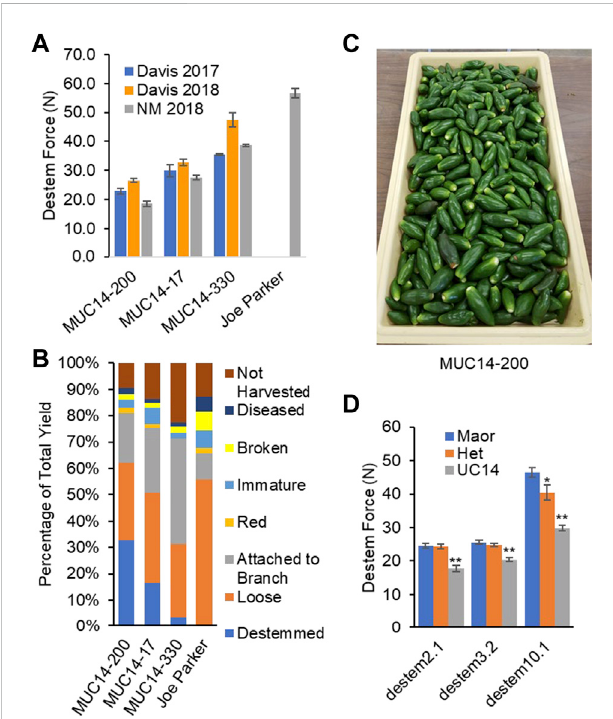
FIGURE 3 Machine harvest trial in 2018. (A) Lower destemming force (N) was correlated withthepercentageofgreen destemmed fruitsfroman Etgar harvester. (B) Percent fruit classes: Destemmed is the mechanically harvested green marketable fruits perfectly destemmed, Loose is the mechanically harvested green marketable fruits with stem attached, and Attached to branch is the green marketable fruits born on harvested branches. Non-marketable fruits mechanically harvested are categorizedintodamaged,red,diseasedandimmature.Notharvestedis the fruits remaining on plants or knocked to the ground and not recovered by the machine during harvest. (C) Fruits cleanly destemmed by the harvester. (D) Destemming force in newtons (N) among genotypes for families segregating at QTL. Plants homozygous for the UCD-14 allele had signi fi cantly lower destemming force (* p < 0.05, ** p <